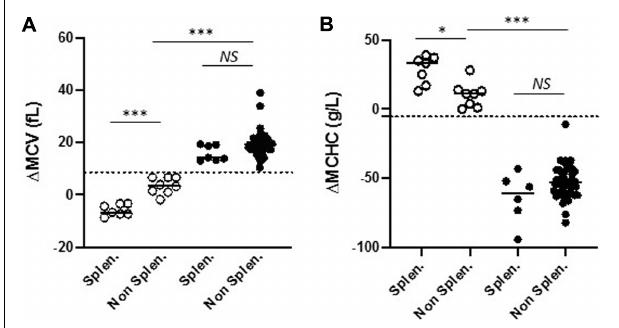
FIGURE 2 | Comparison of (cid:49) MCV (A) and (cid:49) MCHC (B) in splenectomized and non-splenectomized patients in Gardos-HX (o) and Piezo1-HX ( • ). The cut-off value of 8.6 fL and –5.5 g/L, respectively are indicated (dashed line). These differential indices could discriminate between Gardos and Piezo1-HX whether subjects were splenectomized or not. NS, non-significant; ∗ p < 0.05, ∗∗∗ p < 0.001 as measured by one-way ANOVA test and Tukey post hoc analysis for multiparametric